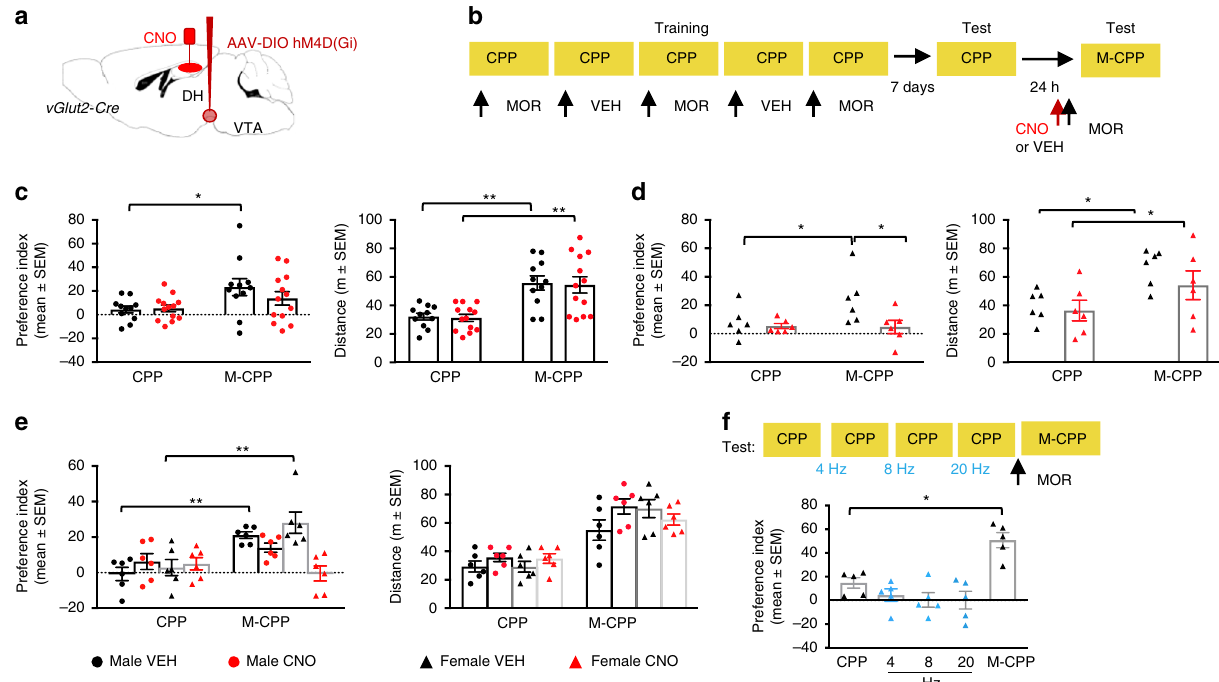
Fig. 5 Silencing VTA → DH terminals impairs reinstatement of M-CPP. a Virus infusion into VTA and cannula implantation in DH. b Mice were trained in M-CPP triggered by a priming dose of morphine. One hour before M-CPP, VEH ( n = 11) or CNO ( n = 13) were injected into DH. c In vGlut2-Cre males, M- CPP was detected in VEH but not CNO group [left, two-way ANOVA, Test effect F (1, 44) = 7.909, P = 0.0073, * P = 0.0498 VEH-CPP vs. VEH-M-CPP, P = 0.5198 CNO-CPP vs. CNO-M-CPP], but there was no group effect (left, two-tailed unpaired t test, t 22 = 1.054, P = 0.3035). Enhanced of locomotion was similar in both groups [right, two-way ANOVA, F (1, 44) = 30.28, P < 0.0001, ** P = 0.0027, VEH CPP vs. M-CPP, ** P = 0.0012, CNO CPP vs. M-CPP]. d In vGlut2-Cre females, CNO ( n = 6) preve n ted M-CPP, as revealed by within subject [two-way ANOVA, F (1, 20) = 4.3, P = 0.0497, * P = 0.0383 VEH CPP vs. M-CPP), and group effects [unpaired two-tailed t -test, t 10 = 2.25, * P = 0.0482 vs. VEH ( n = 6)]. Locomotor activity was not affected (two-way ANOVA, F = 2.26, P = 0.1484), showing increases in both groups (* P < 0.0252 VEH CPP vs. M-CPP, * P = 0.0328 CNO CPP vs. M-CPP). e Sex effects in males (1, 10) ( n = 6) and females ( n = 6). Three-way ANOVA demonstrated sex × treatment interaction [ F (1, 40) = 5.276, P = 0.0269], with M-CP P in VEH groups only (** P = 0.0099 males and ** P = 0.0018 females), and similar locomotion [ F (1, 40) = 3.366, P = 0.0740]. f Females ( n = 5) received optoge n etic stimulation on consecutive days followed by a priming dose of morphine. RM one-way ANOVA revealed signi fi cant effect of treatment, F (2.167, 8.66) = 16.36, P = 0.0009, however, while morphine-induced place preference (M-CPP vs. CPP, * P = 0.0465), stimulations were ineffective (4 Hz vs. CPP P = 0.5109, 8